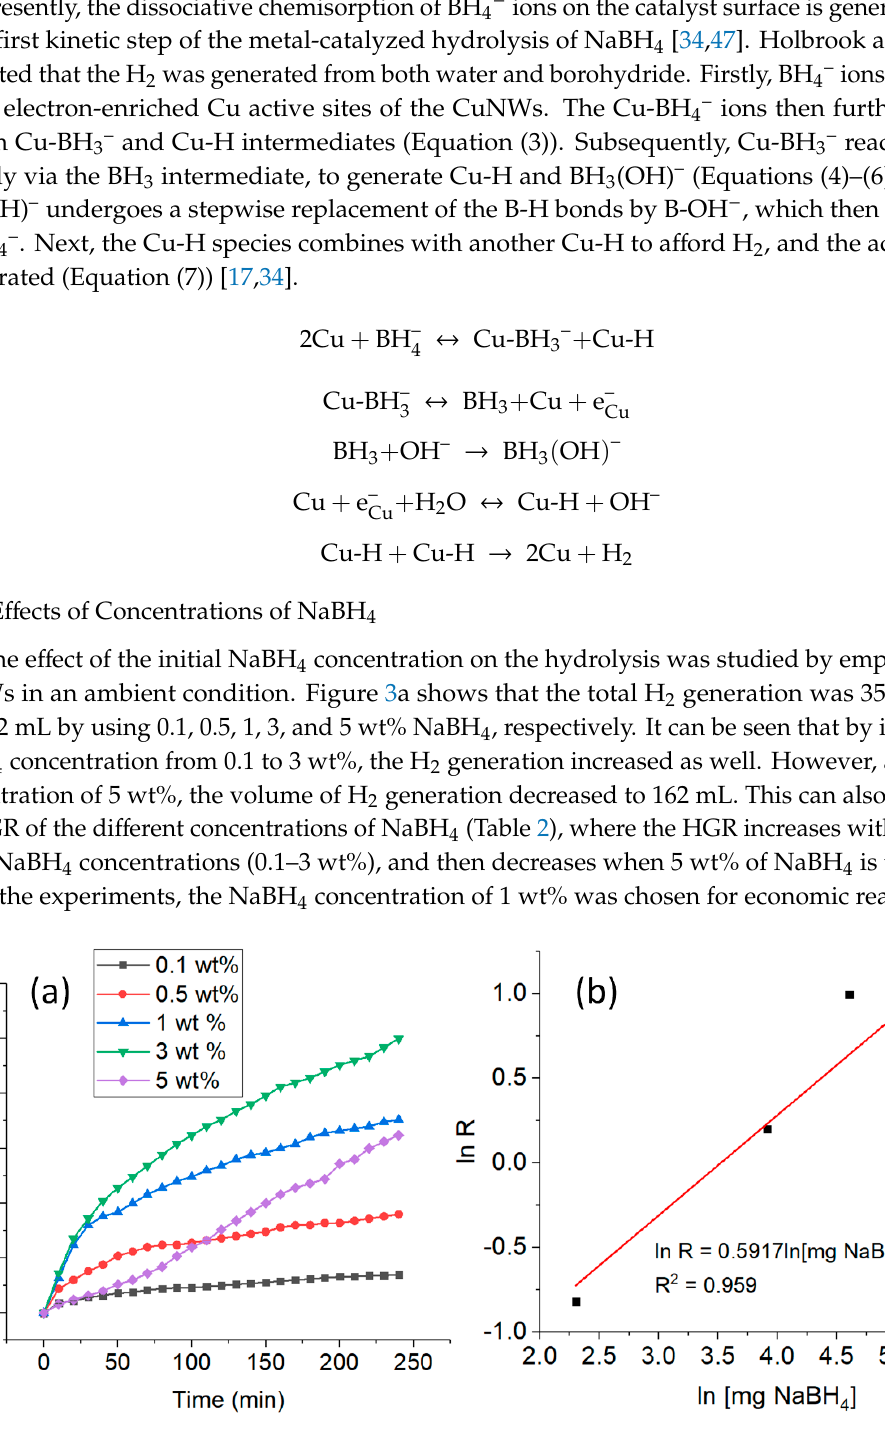
Figure 3. Plot of ( a ) different NaBH 4 concentrations (wt%) on H 2 generation versus time; and ( b ) HGR versus NaBH 4 concentrations, both in logarithmic scale. (Conditions: CuNWs = 0.1 ng, pH = 12, and temperature = 298 K).